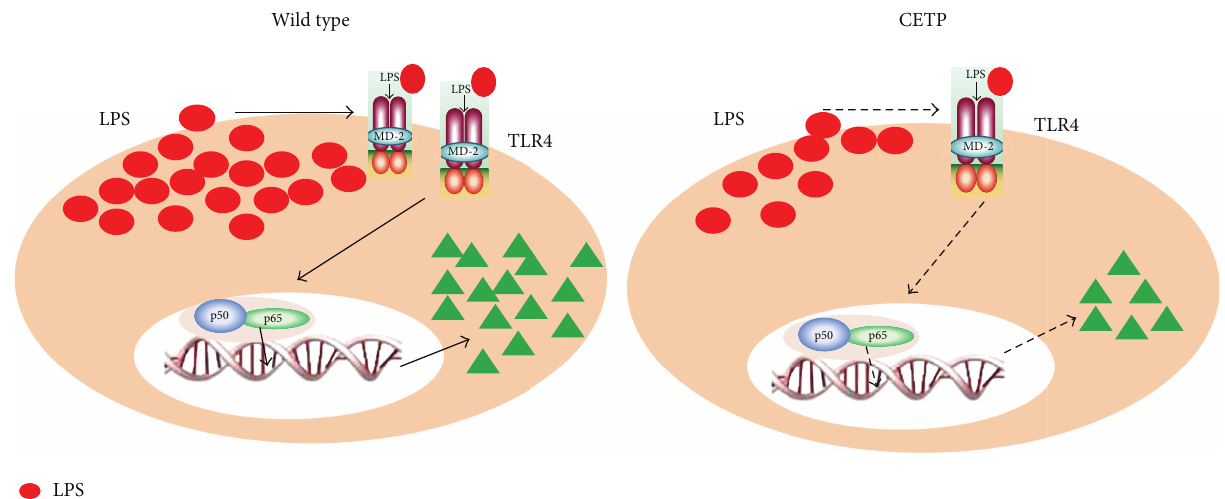
Figure9:ThepresenceofCETPreducedthecellularuptakeofLPS,TLR4expression,andNF- 𝜅 Bactivation(p65)andconsequentlydecreased the secretion of IL-6 indicating that CETP interferes in TLR4 signaling